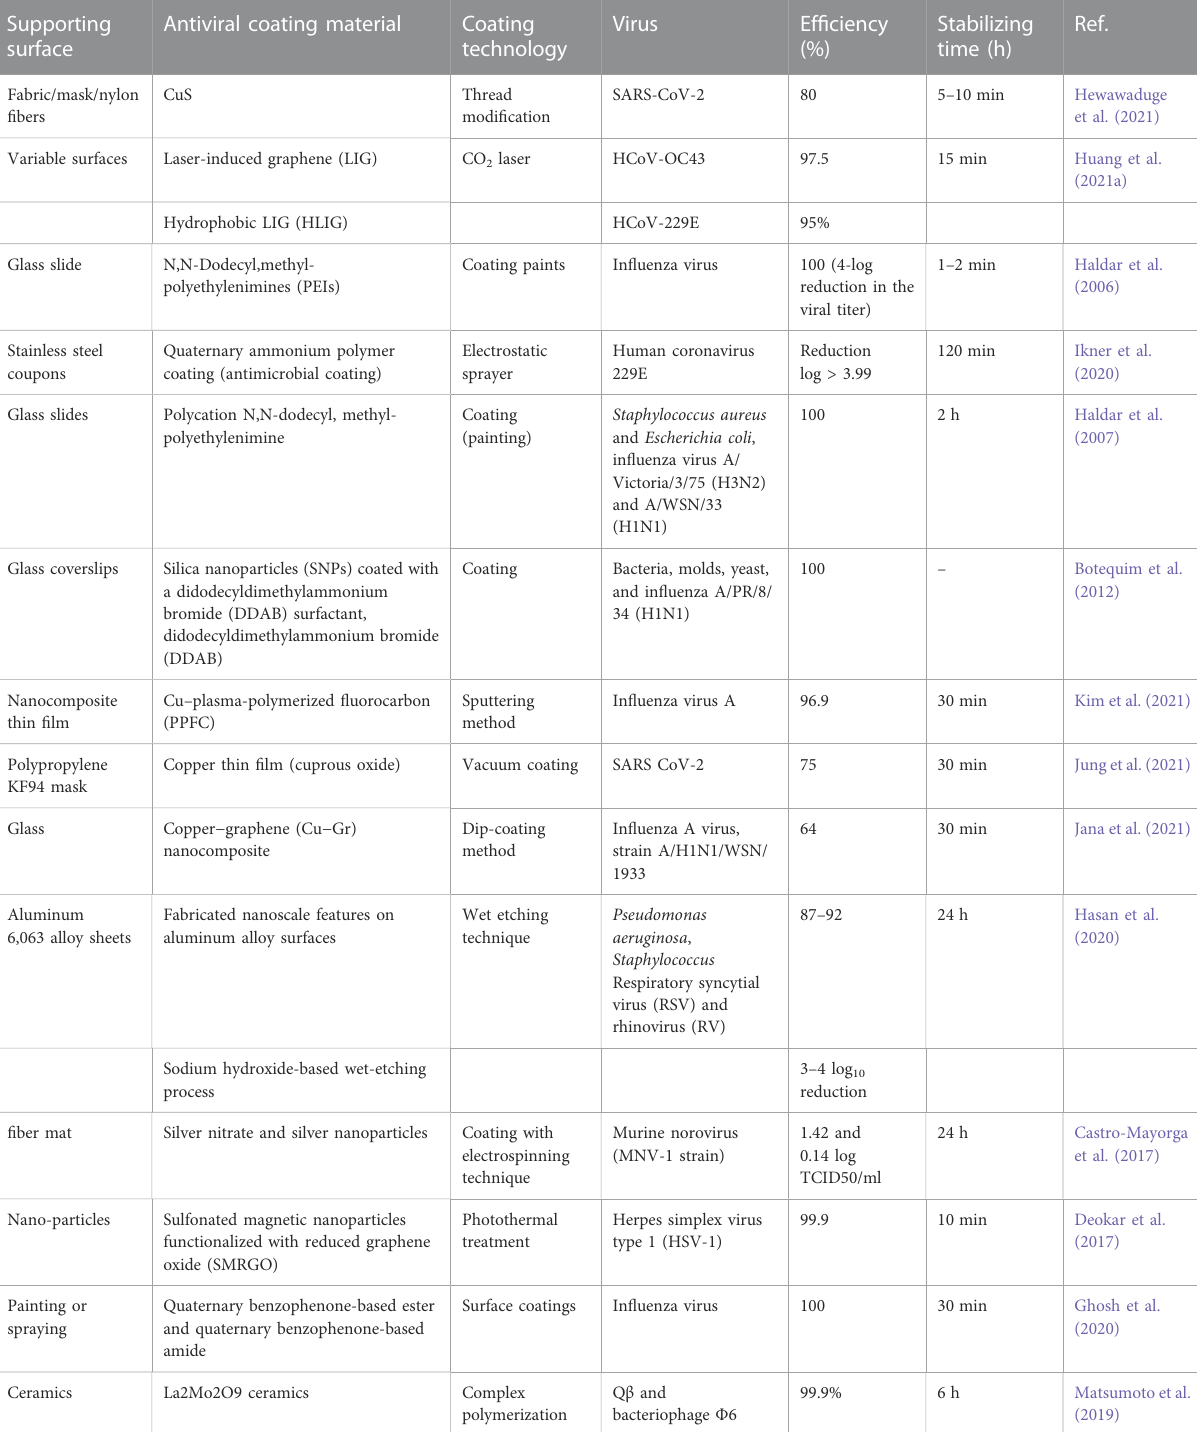
TABLE 2 Deposition methods for preparing antiviral